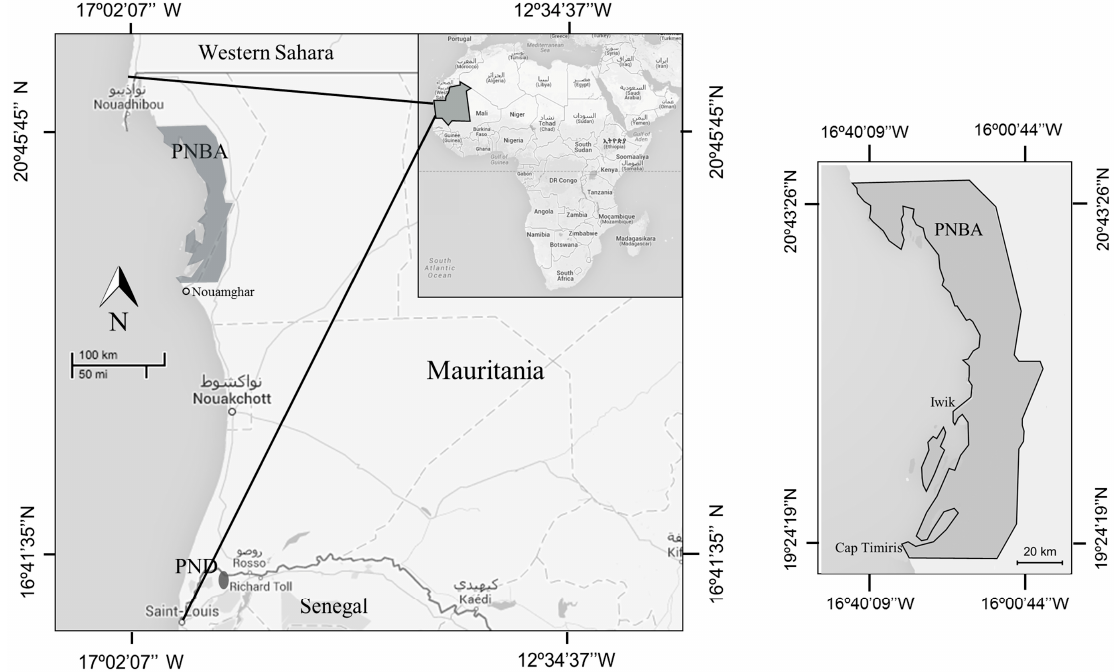
Figure 1. The study site Cap Timiris at Parc National du Banc d’Arguin (PNBA), Mauritania. The Iwik area and the Parc National du Diawling (PND) are also indicated (see text). Adapted from Google Maps (2016).